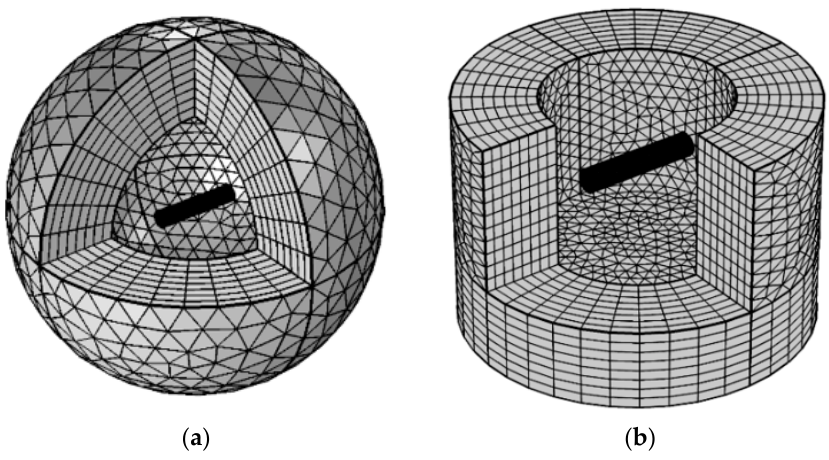
Figure 3 . The sound radiation model for a structure: ( a ) free field and ( b ) half-space. Figure 3. The sound radiation model for a structure: ( a ) free field and ( b )